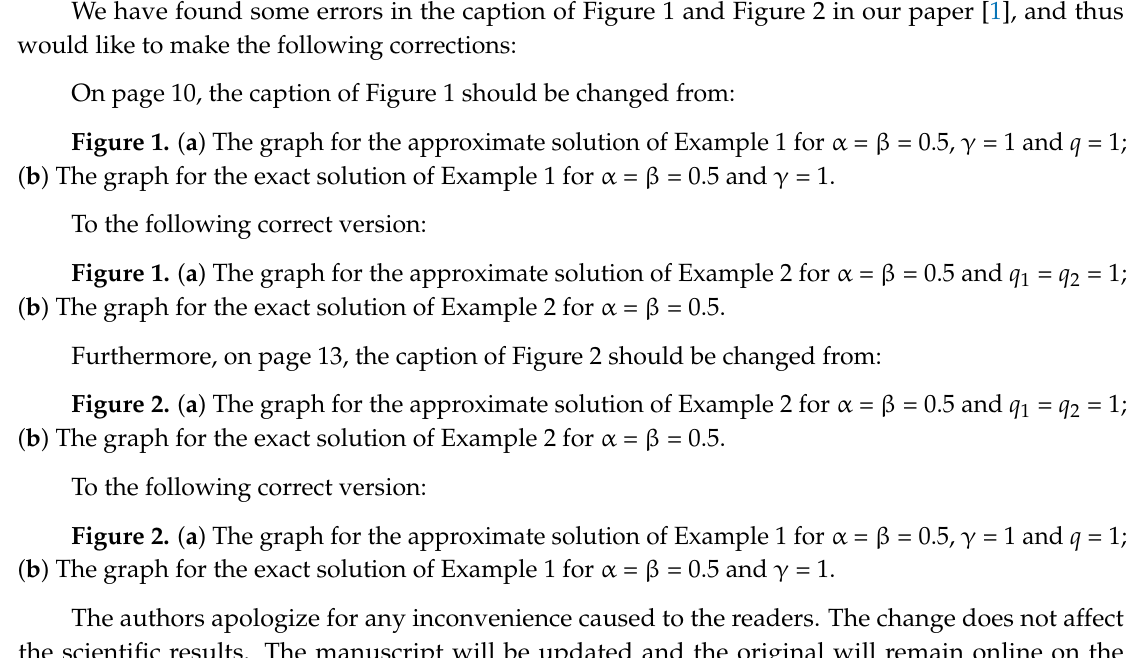
( b ) The graph for the exact solution of Example 1 for α = β = 0.5 and γ =